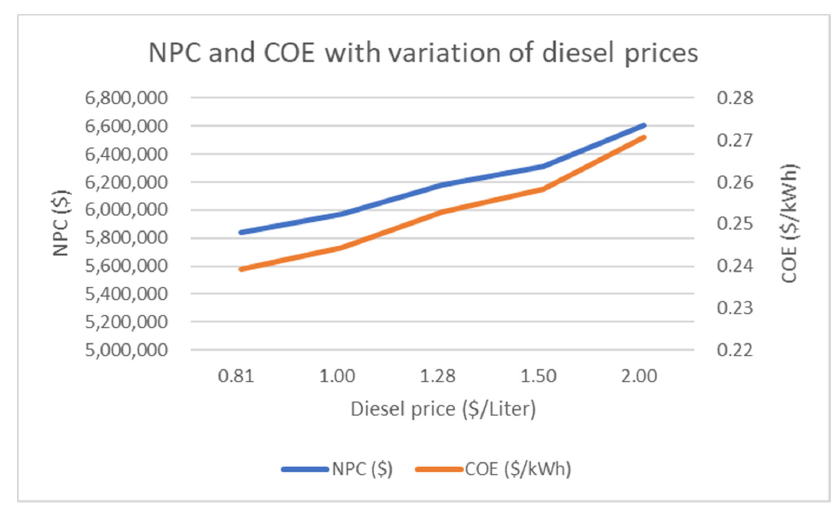
Figure 9. NPC (Net Present Cost) and COE (Cost Of Energy) with variation of diesel prices.